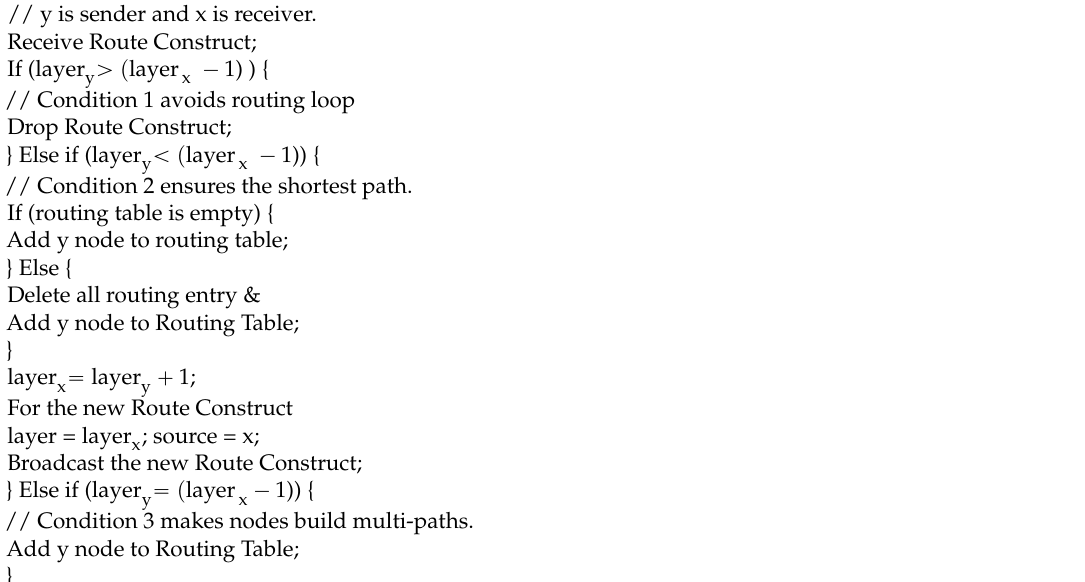
Table 1. Route Construct